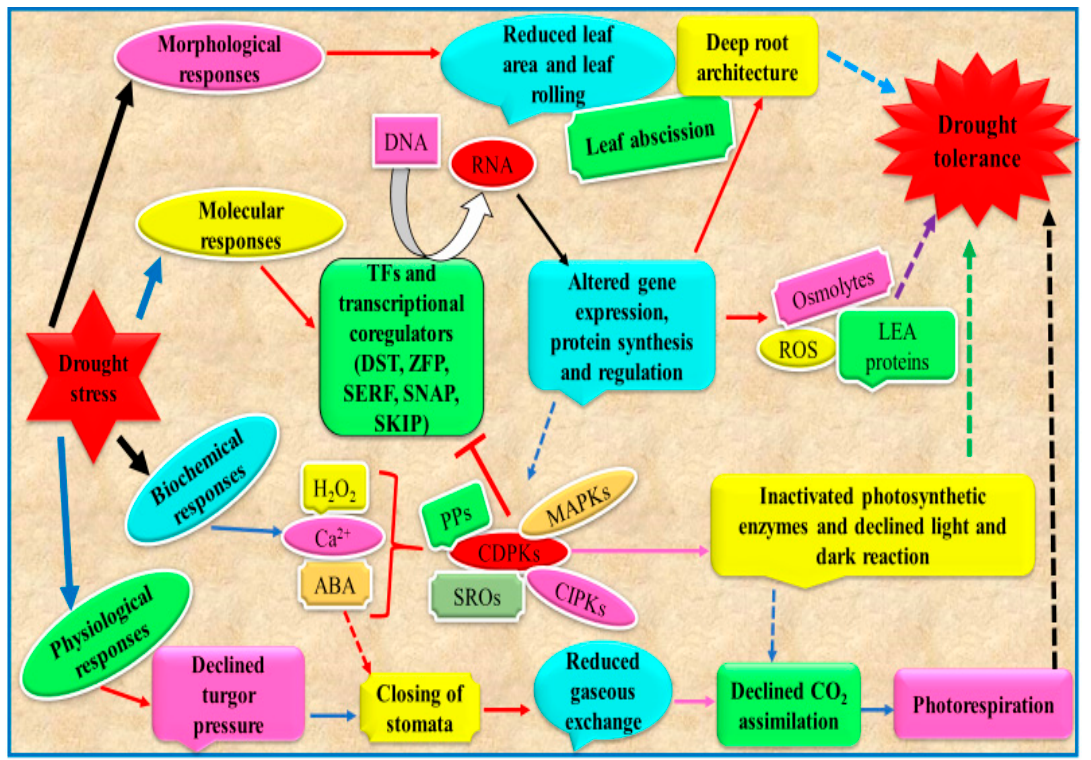
Figure 4. Diagram showing plants drought tolerance mechanism. TFs, transcription factors; DST, drought and salt tolerance; SERF, serum response factor; SKIP, ski-interacting protein; ZFP, zinc finger TF; SNAC, stress responsive NAC TF; LEA, late embryogenesis abundant; ABA, abscisic acid; SROs, similar to RCD-ONE; CDPKs, Ca 2+ dependent protein kinases; MAPKs, mitogen activated protein kinases; PPs, protein phosphatases; CIPKs, CBL interacting protein kinases (modified from Zargar et al. [118]).